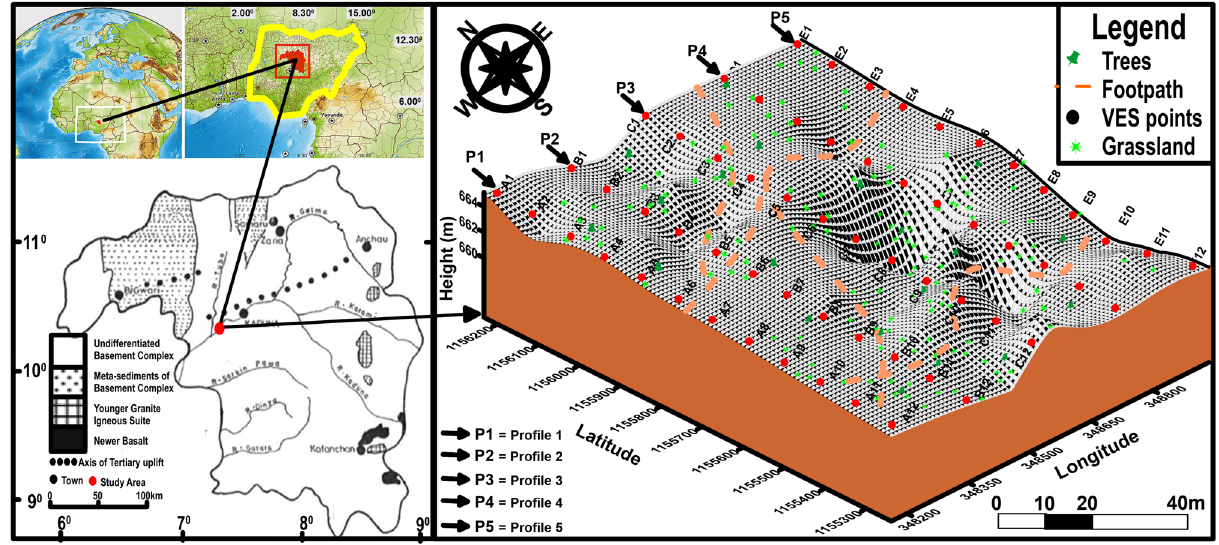
Fig. 1 Map of study area showing the VES points, the profiles and their